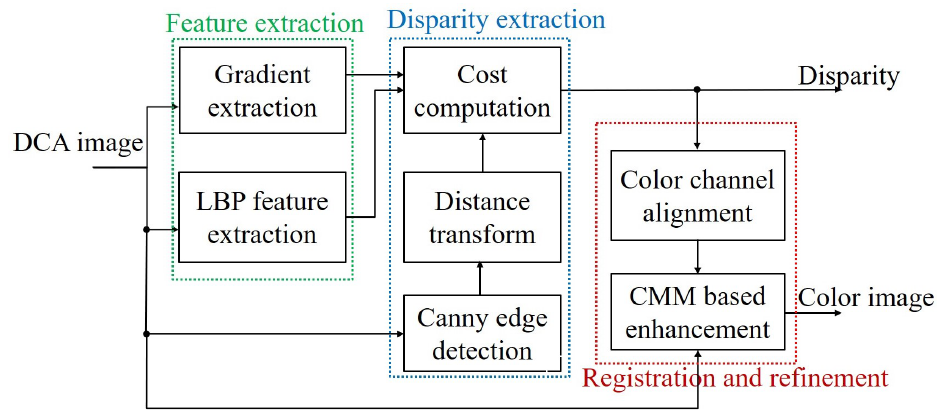
Figure 4. Block diagram of the proposed system. CMM, color mapping